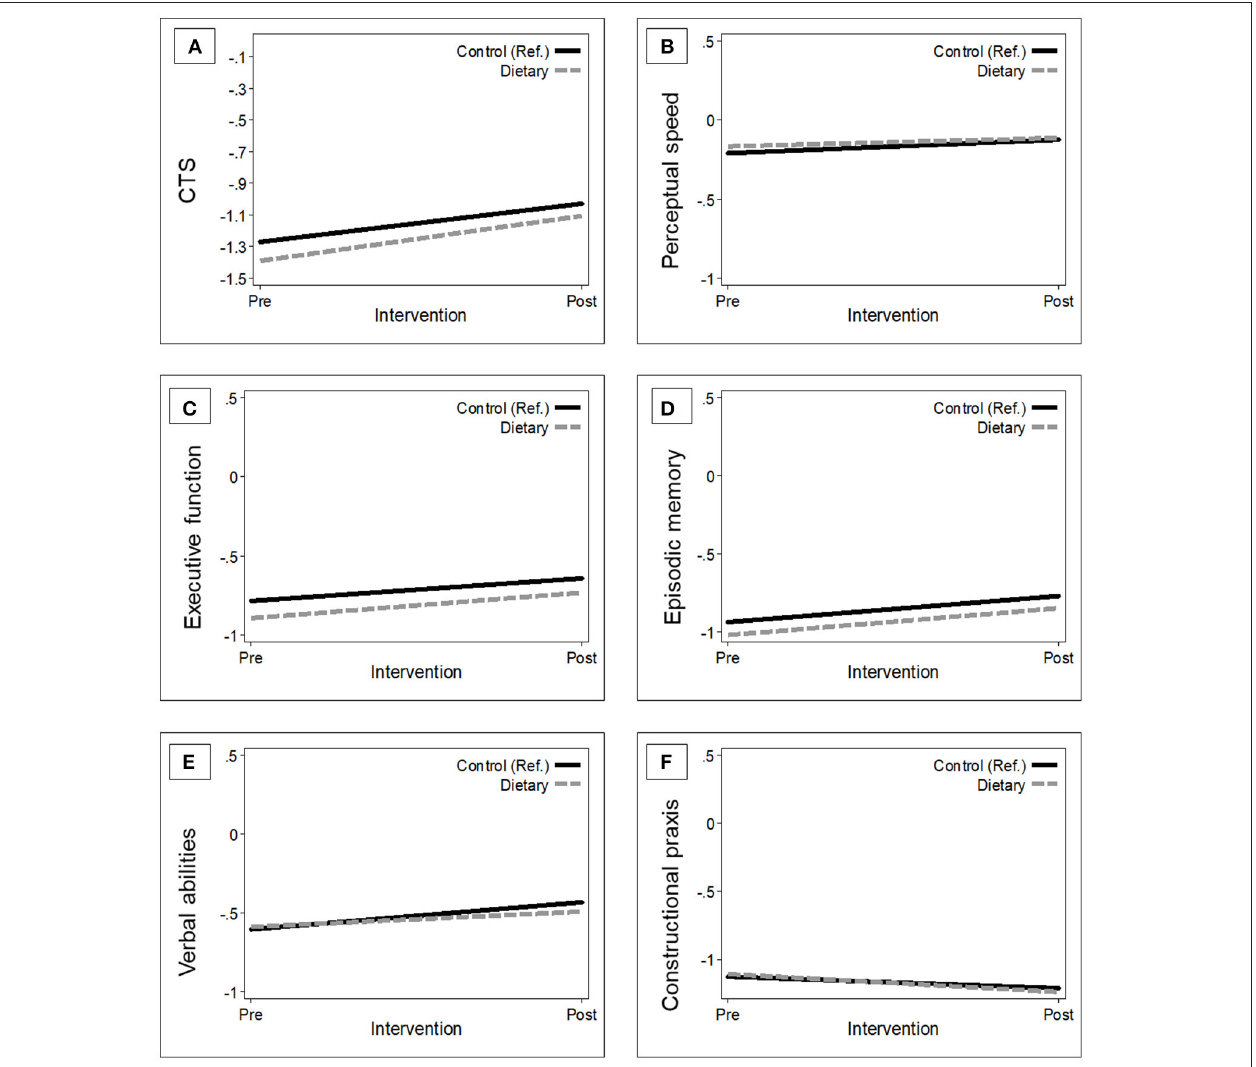
FIGURE 1 | Estimated trajectories of change in global and domain-specific cognitive function 1-year after randomization by group. The figure shows the changes in global cognition (A) , perceptual speed (B) , executive functions (C) , episodic memory (D) , verbal abilities (E) , and constructional praxis (F) in the control group [ n = 641; (reference); black solid line] vs. intervention group ( n = 638; gray dash line). Mixed-effect models were adjusted for baseline age, sex, education, country, and interviewer. The trajectories were plotted using the mean values of the covariates. CTS, CERAD total score.